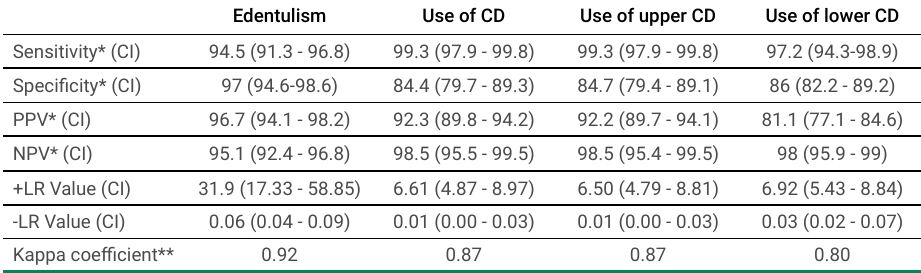
Table 3. Validation of self-reported oral health condition according to clinical oral condition in older people without cognitive deficit. Edentulism Use of CD Use of upper CD Use of lower